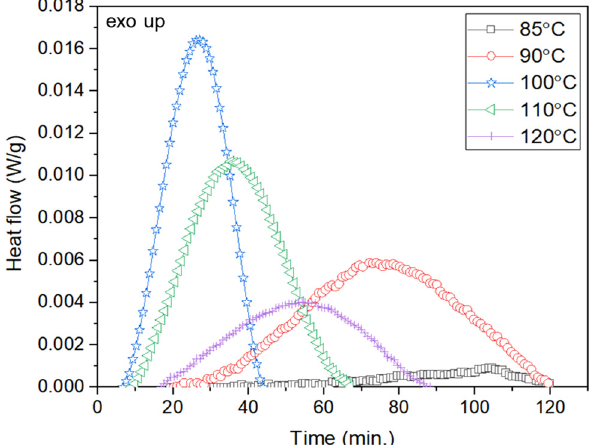
Figure 7: Isothermal DSC results obtained from crystallization at di ff erent set temperatures ( 85°C, 90°C, 100°C, 110°C, and 120°C ) .